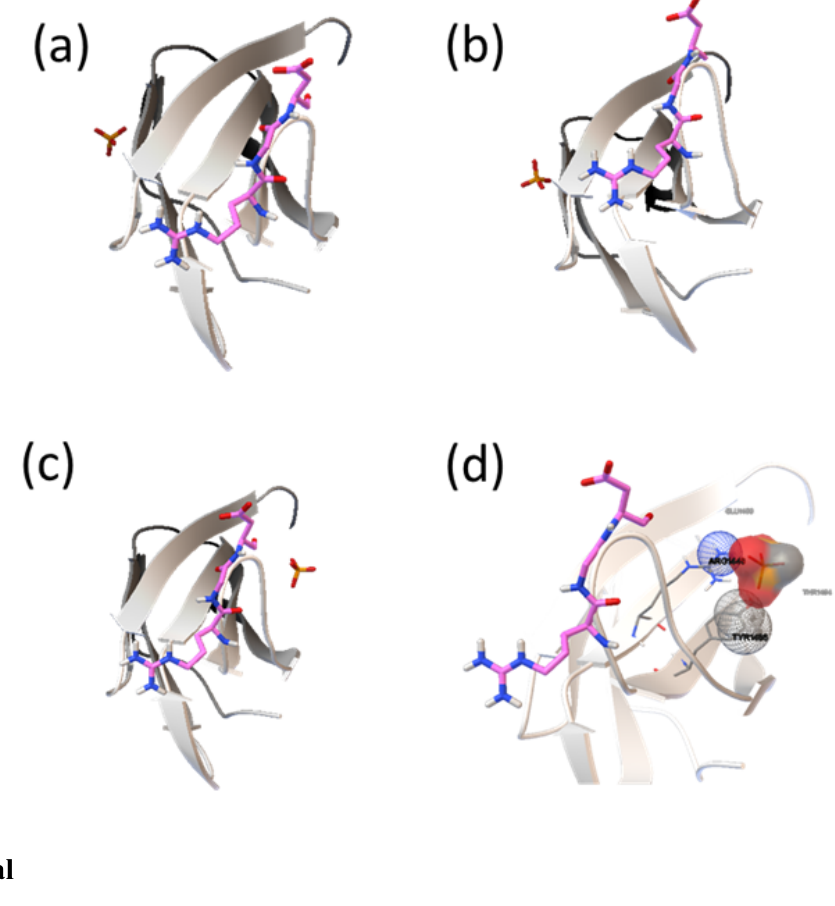
Figure 5. Binding model of FNIII (carton model) and HAP molecular (stick) near RGD 10 loop (stick model). ( a ) cluster 1, ( b ) cluster 2, ( c ) cluster 3 and ( d ) further analysis about cluster 3 for the HAP binding sites near the RGD